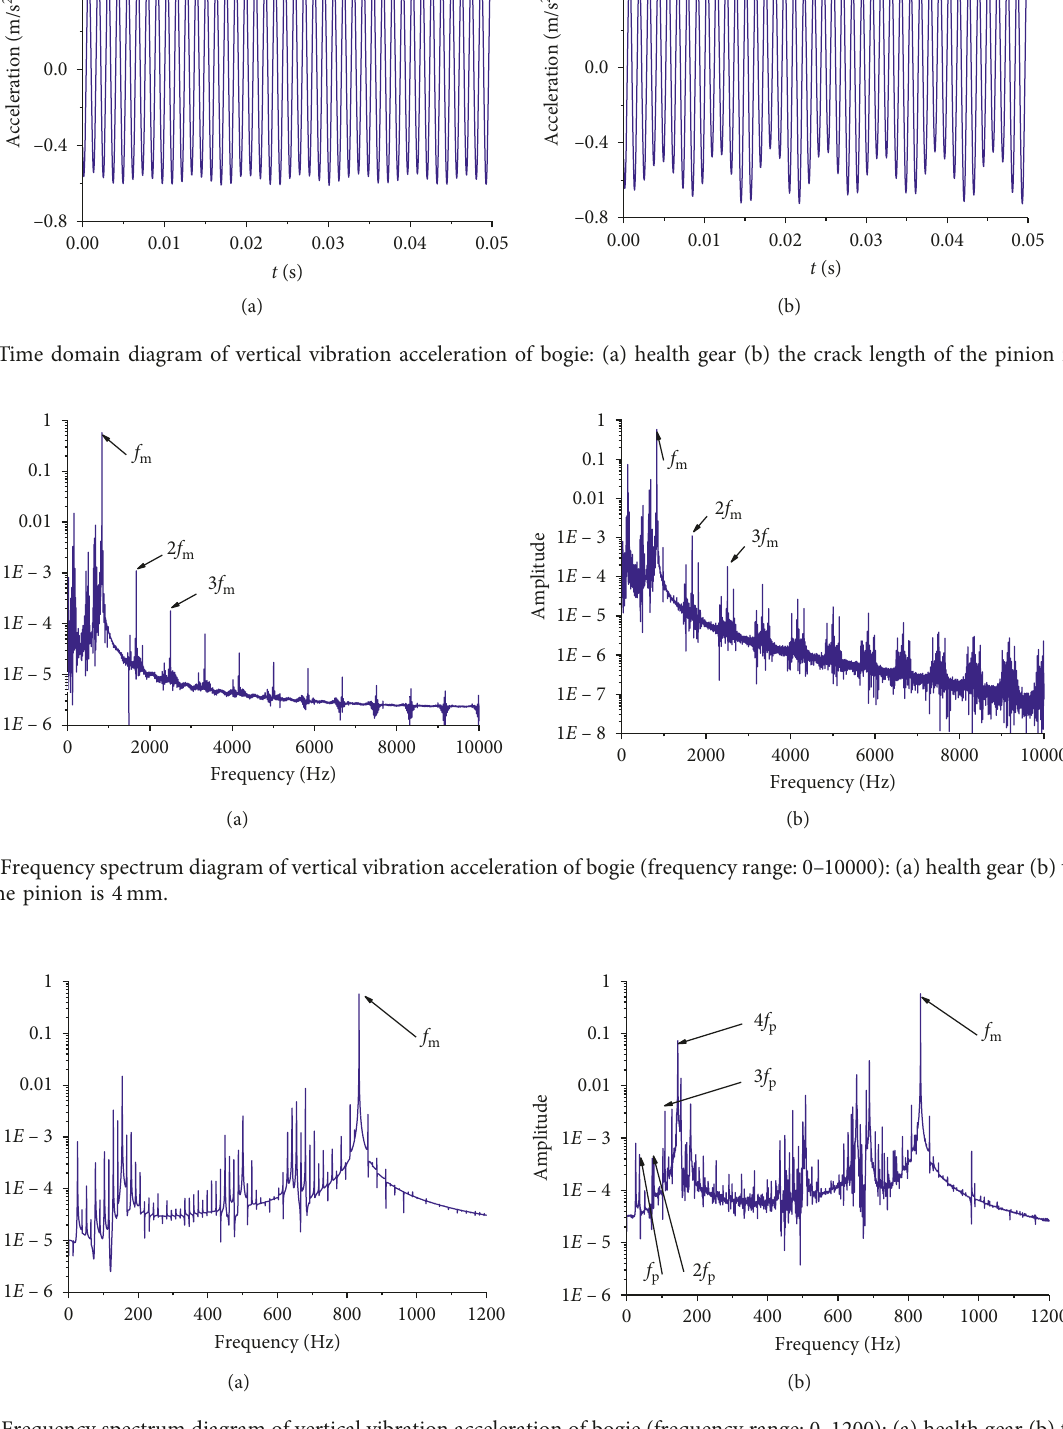
Figure 11: Frequency spectrum diagram of vertical vibration acceleration of bogie (frequency range: 0–1200): (a) health gear (b) the crack length of the pinion is